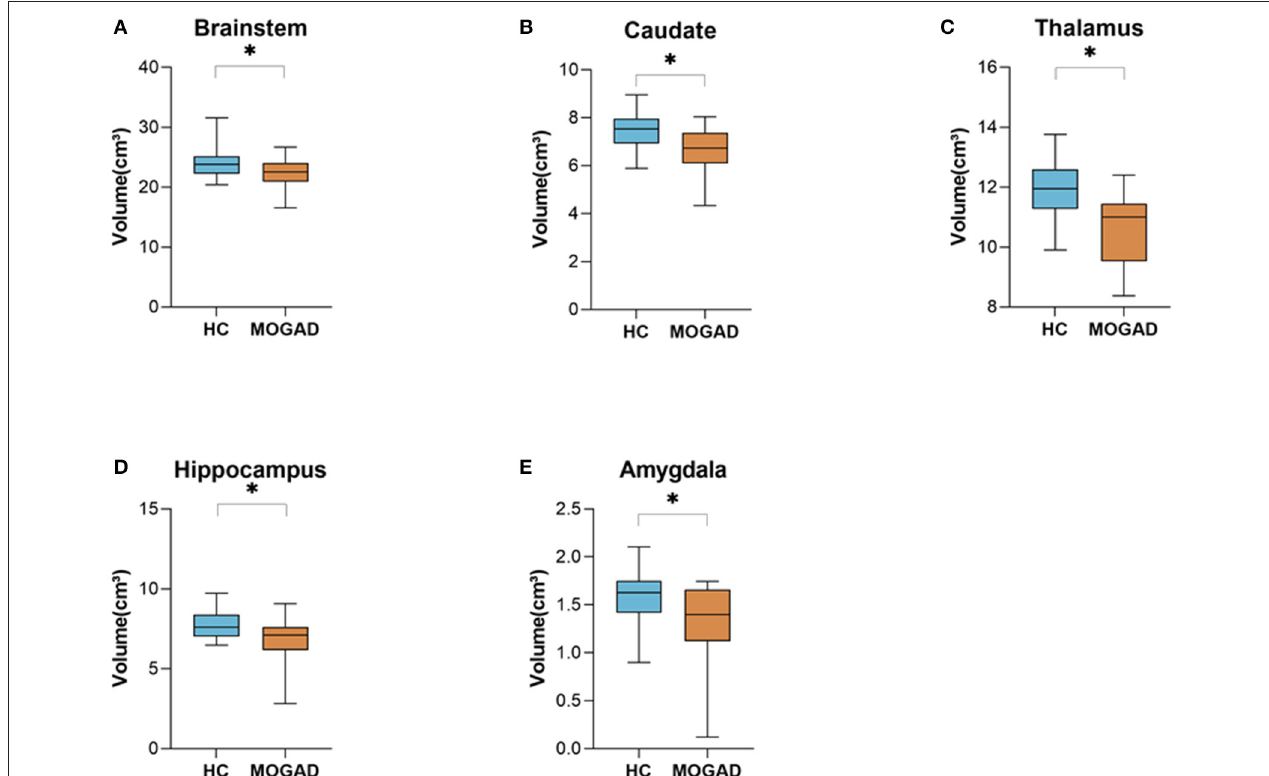
FIGURE 2 | Decrease brain volume of MOGAD patients during the first year of diagnosis. Brain volume of HCs ( n = 22) and MOGAD patients during the first year of diagnosis ( n = 15) analyzed by Volbrain software. (A) Volume of brainstem (23.96 ± 2.49 vs. 22.13 ± 2.48, p = 0.035), (B) caudate (7.46 ± 0.79 vs. 6.68 ± 1.03, p = 0.010), (C) thalamus (11.92 ± 0.99 vs. 10.99 ± 1.67, p = 0.040), (D) hippocampus 7.78 ± 0.83 vs. 6.82 ± 1.41, p = 0.021), and (E) amygdala (1.60 ± 0.27 vs. 1.32 ± 0.41, p = 0.021) of MOGAD patients during the first year of diagnosis and HCs. MOGAD, Myelin oligodendrocyte glycoprotein antibody disorders; HCs, healthy controls. p * ≤